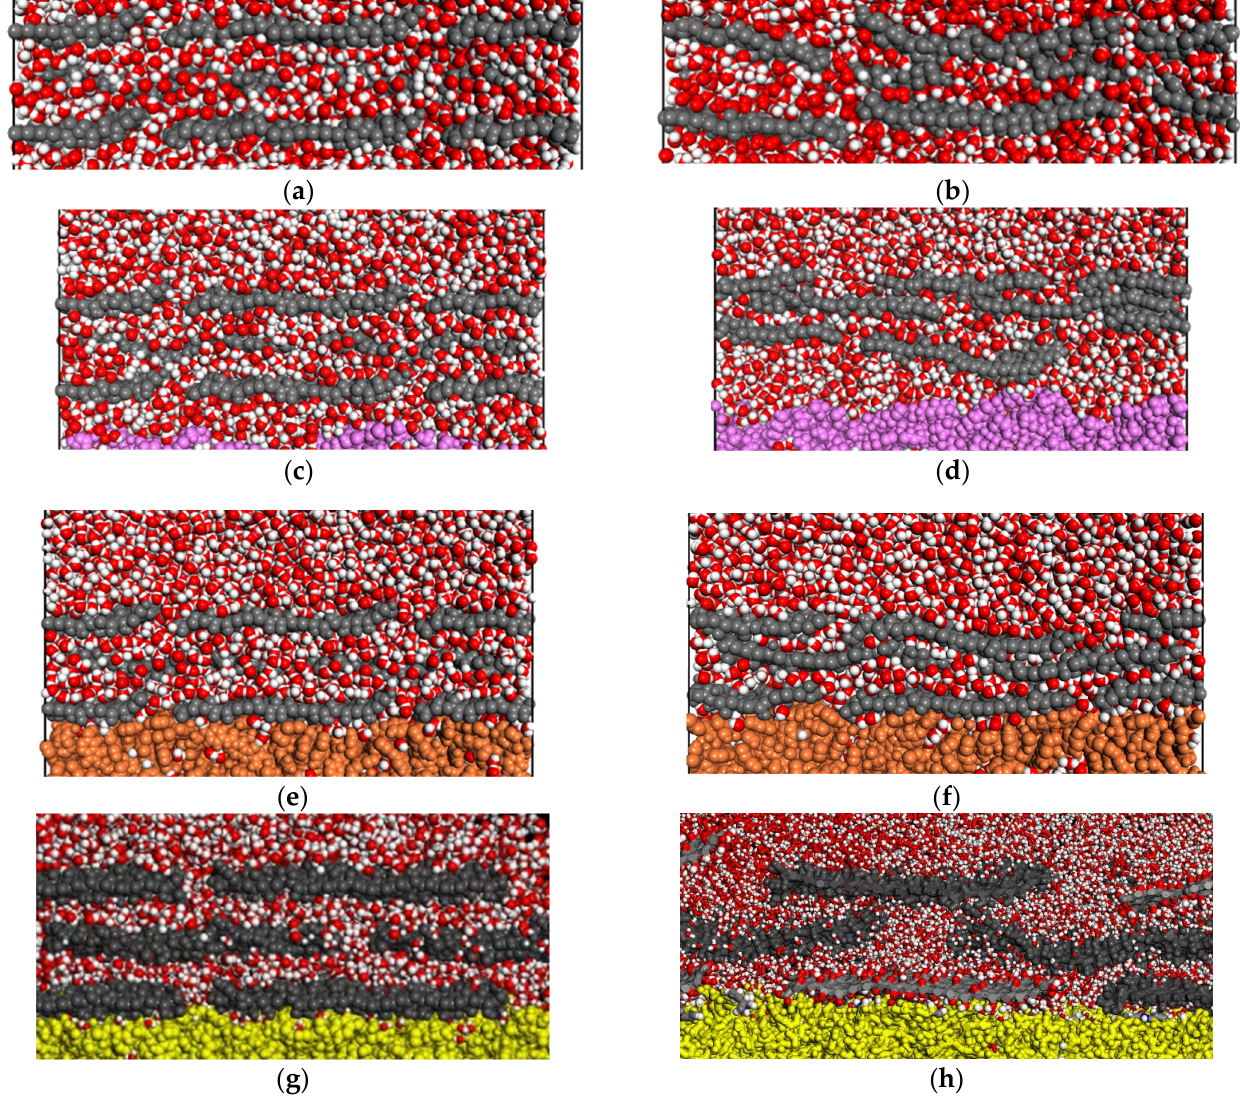
Figure 3. GO sheets at the beginning and end of the simulation: ( a , b ) GO in water; ( c , d ) PVDF (pink); ( e , f ) PAI (orange); ( g , h ) PAI–cr (yellow). In all pictures, the colors are O = red; H= white, GO layer = deep grey.